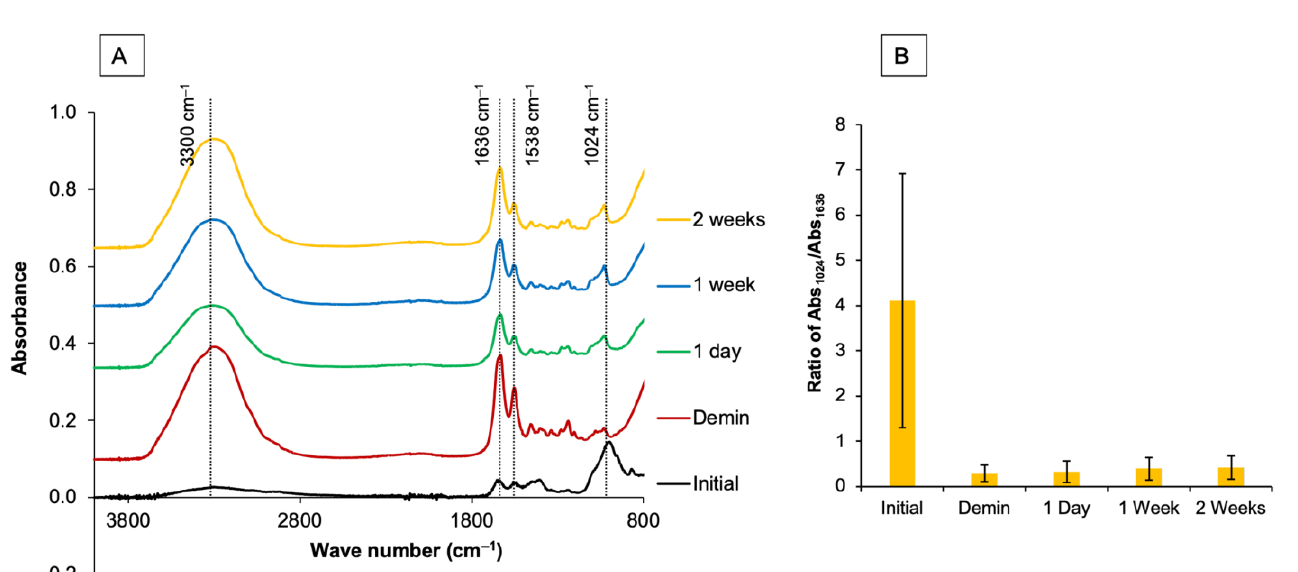
Figure 2. ( A ) Example of FTIR spectra of a specimen from the 60 s group prior to the demineralization process. A strong peak of the phosphate group in mineral apatite (1024 cm − 1 , PO 43 − stretch) was detected. After demineralization, peaks representing type I collagen, such as 1636 cm − 1 (C=O stretch, amide I), 1538 (amide II, C-N stretch), and 3300 cm − 1 (amide A), were stronger than the peak attributable to apatite. ( B ) The area of the FTIR peak at 1024 cm − 1 versus 1636 cm − 1 was then obtained to determine the mineral precipitation in dentin.